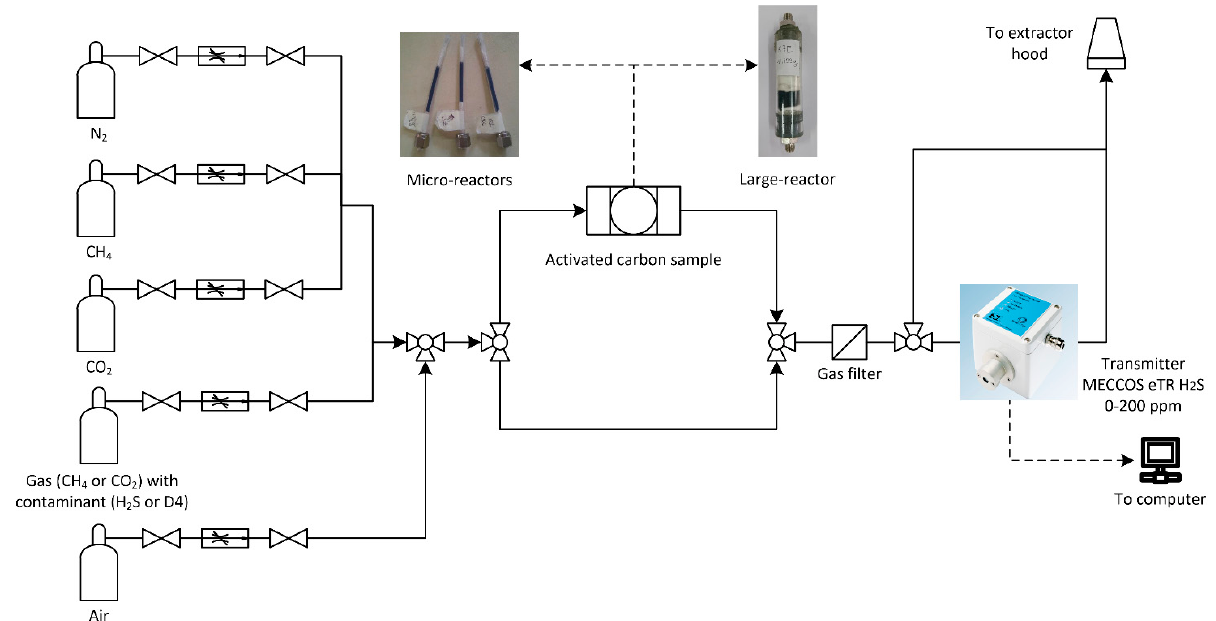
Figure 2. The layout of the experimental apparatus. The adsorption capacity can be typically evaluated at breakthrough or